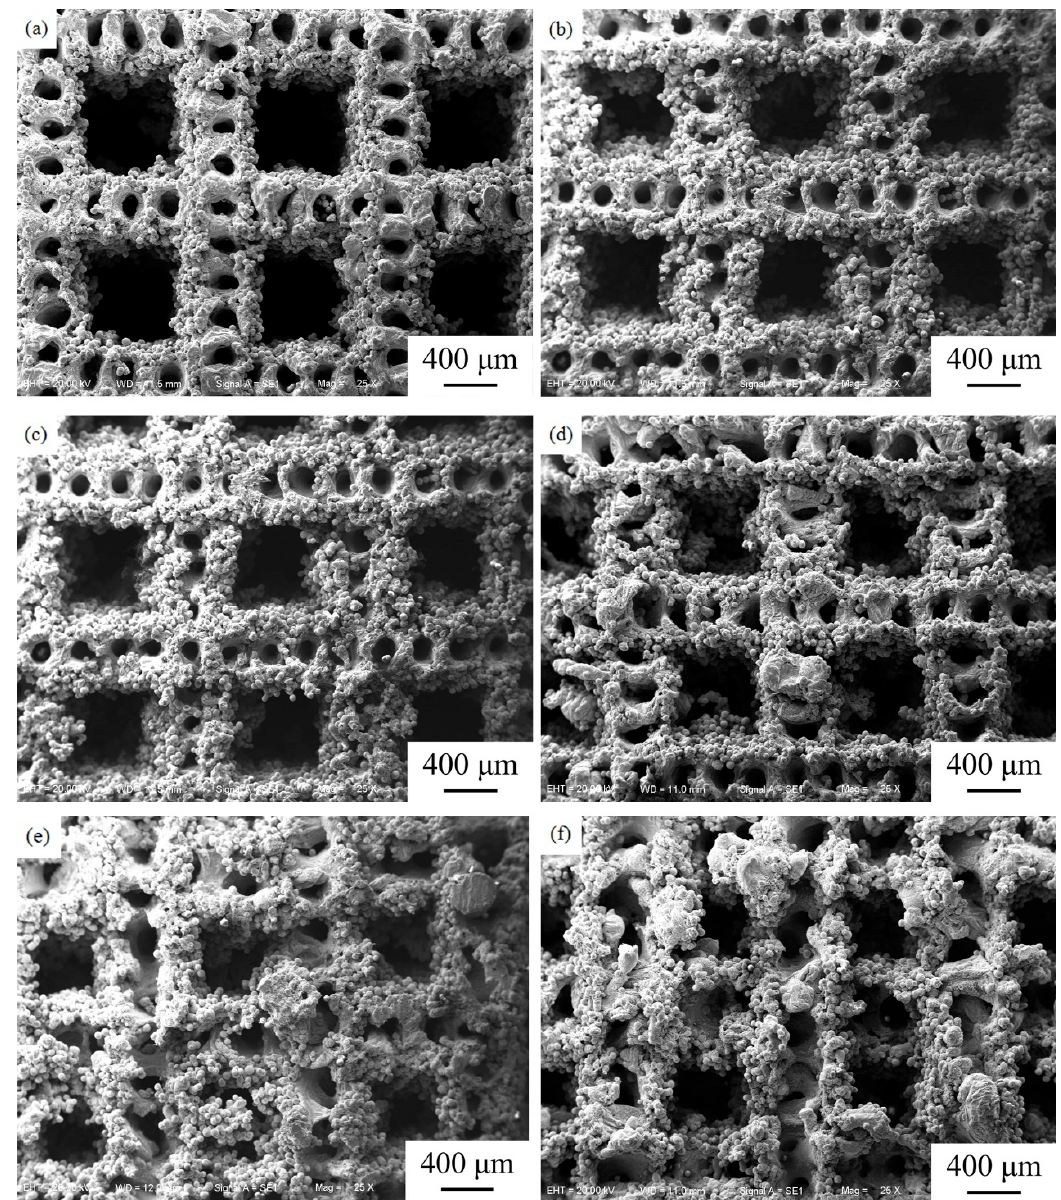
Figure 3. Cross-section morphologies of the LAMed ZK61 prepared at different E . ( a ) 764 J/mm 3 , ( b ) 892 J/mm 3 , ( c ) 1019 J/mm 3 , ( d ) 1146 J/mm 3 , ( e ) 1273 J/mm 3 , ( f ) 1400 J/mm 3 .